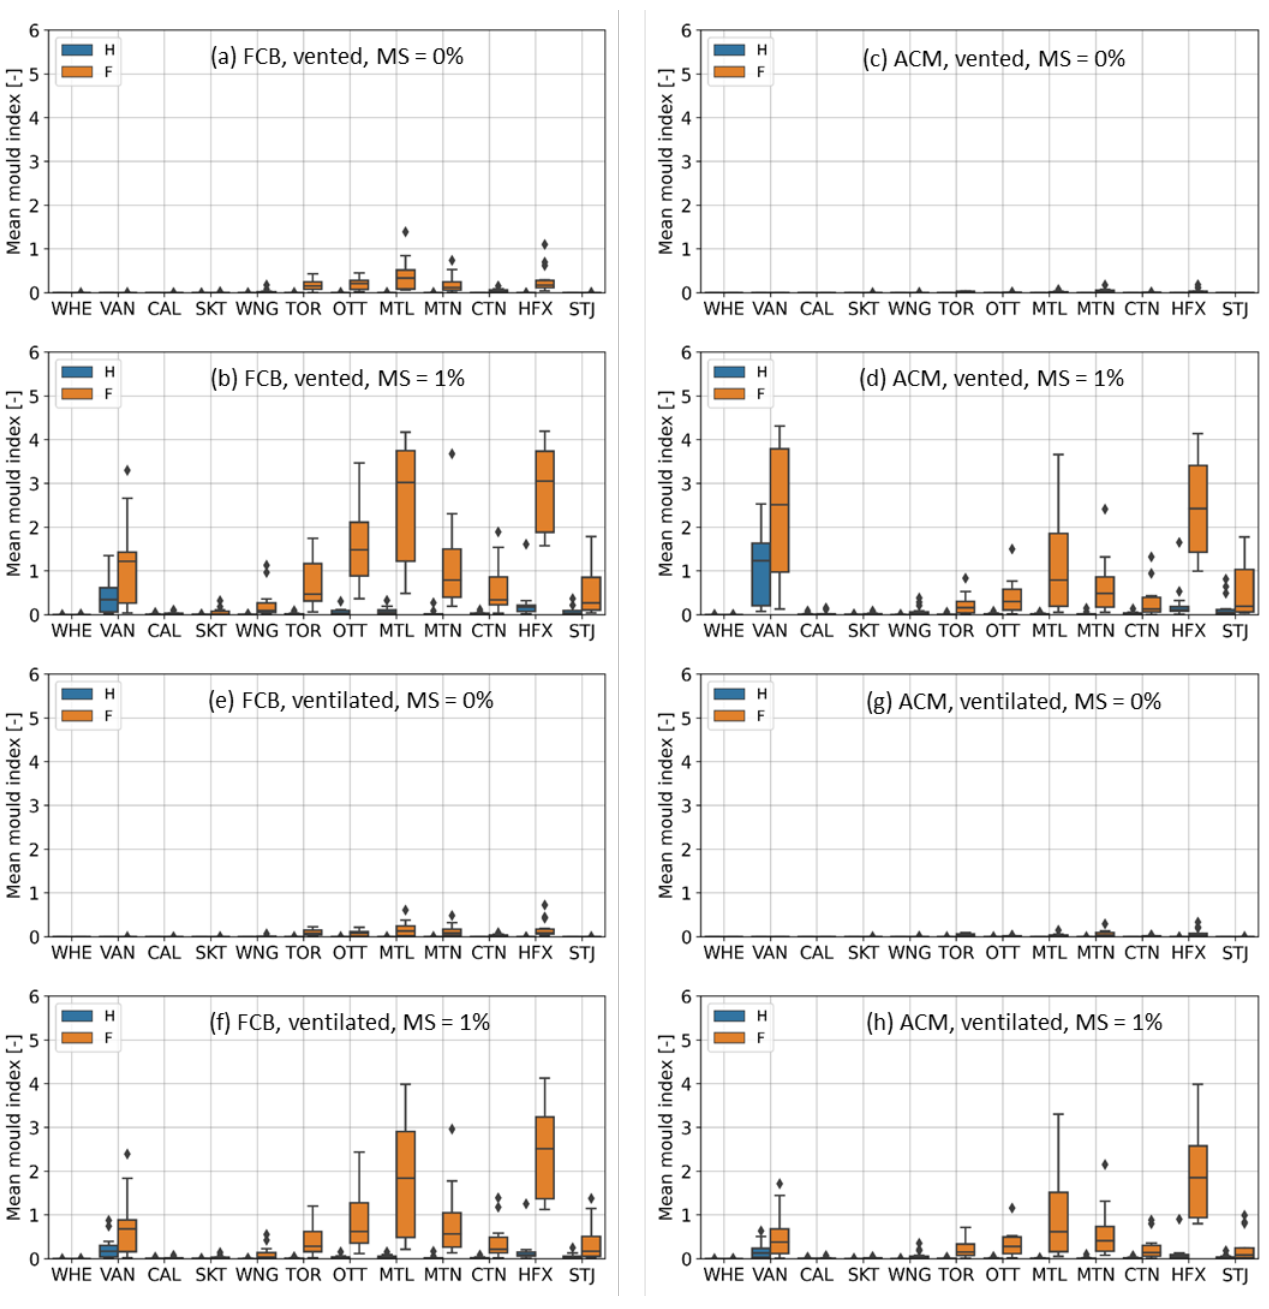
Figure 9. Boxplots of the mean values of mold growth indices on the outer surface of CLT panel obtained for fiber cement (FCB: ( a , b , e , f )) and aluminum composite material (ACM: ( c , d , g , h )) walls under historical (H) and future (F) periods, for vented ( a – d ) and ventilated ( e – h ) cladding and for the case with ( b , d , f , h ) and without ( a , c , e , g ) moisture source (MS).